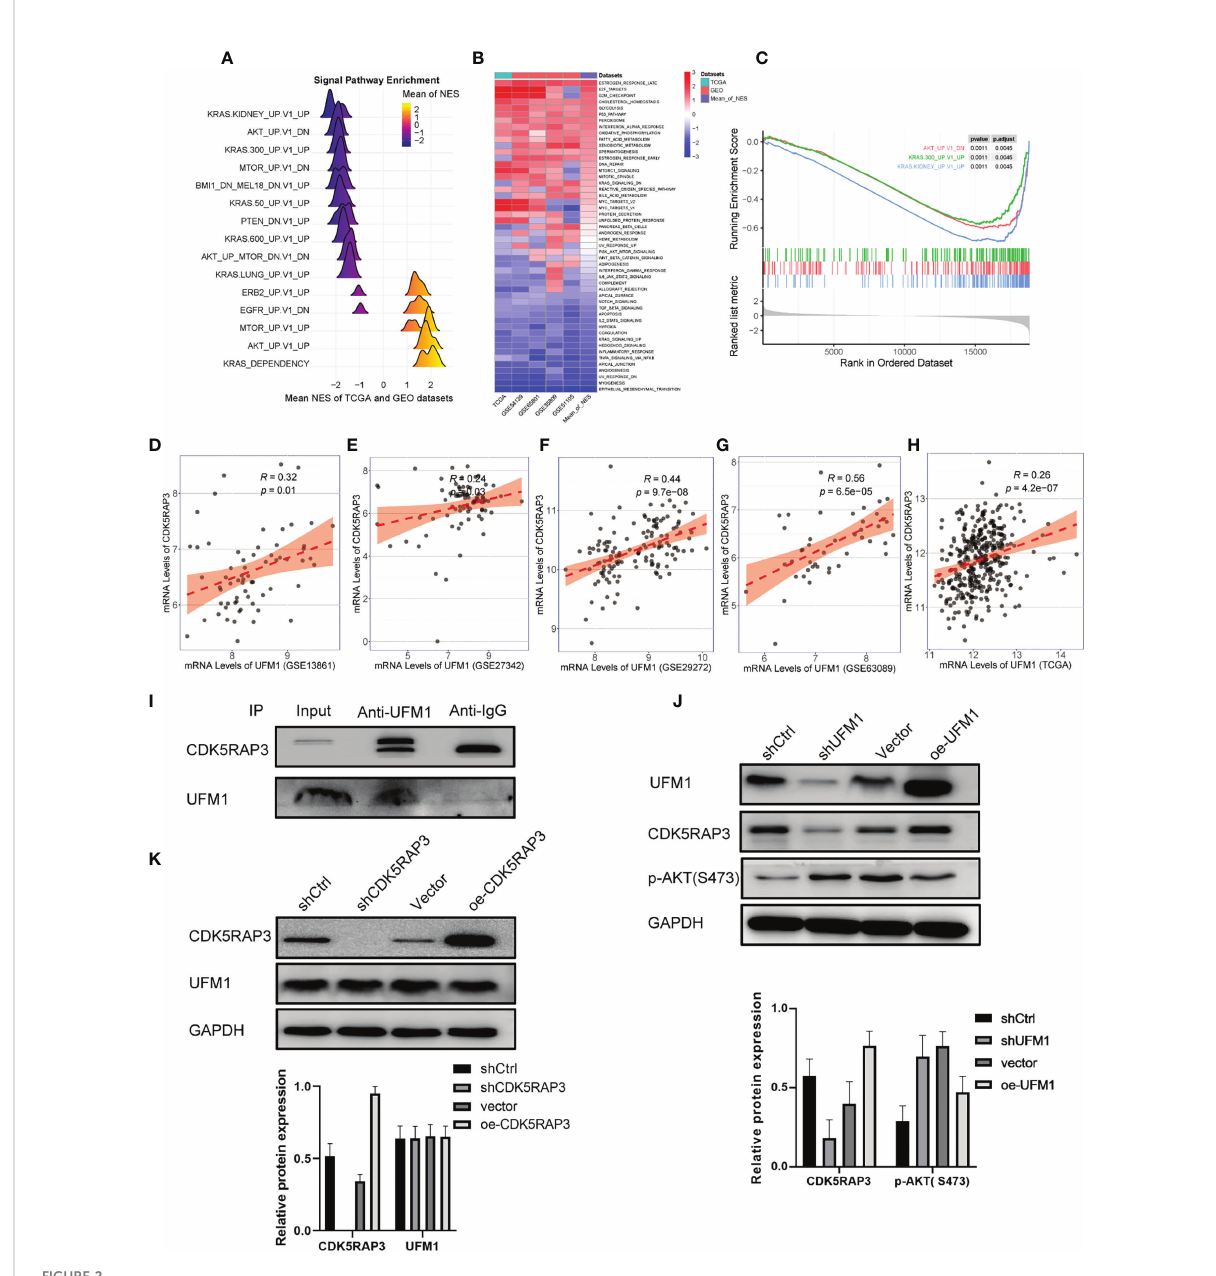
FIGURE 2 Pathway enrichment analysis of CDK5RAP3 and the correlation between UFM1 and CDK5RAP3 expression. (A) Mountain map of signal pathway enrichment. (B) Heatmap showing the activation status of the biological processes in different data sets. (C) GSEA enrichment analysis map for CDK5RAP3. (D) Pearson ’ s correlation of UFM1 and CDK5RAP3 expression in GSE13861. (E) Pearson ’ s correlation of UFM1 and CDK5RAP3 expression in GSE27342. (F) Pearson ’ s correlation of UFM1 and CDK5RAP3 expression in GSE29272. (G) Pearson ’ s correlation of UFM1 and CDK5RAP3 expression in GSE63089. (H) Pearson ’ s correlation of UFM1 and CDK5RAP3 expression in TCGA. (I) Co- immunoprecipitation using anti-UFM1 antibody to pull down the bait protein was used to detect the binding of CDK5RAP3 and UFM1 in the overexpressing UFM1 HGC-27 cells, with input as the positive control and anti-IgG as the negative control. (J) Western blot analysis of CDK5RAP3 and PAKT with knockdown and overexpression of UMF1 in the HGC cell line. (K) Western blot analysis of UFM1 with knockdown and overexpression of CDK5RAP3 in the HGC cell